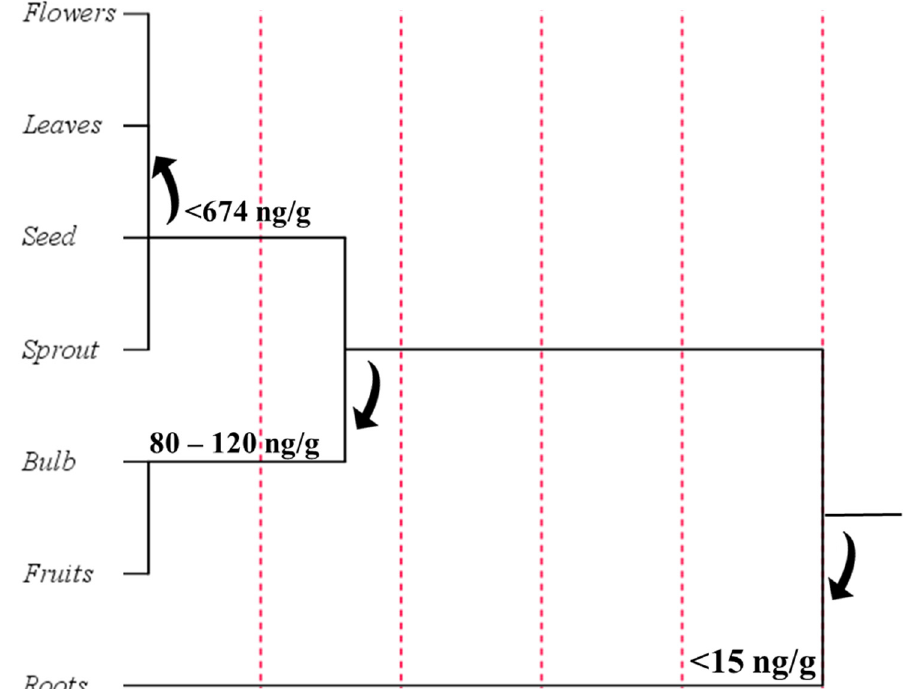
Figure 12. Cluster distribution of melatonin in plant organs, according to previously published data [38,115,129–173]. Euclidean distances were calculated with centroid method. Statistical analysis and graphical representation were made using SPSS v. 24 software.